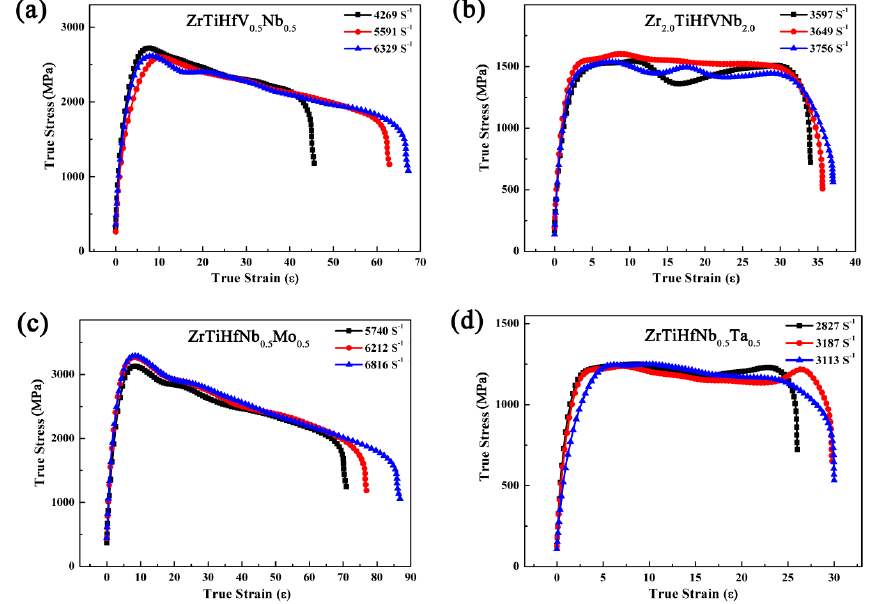
Figure 11. The dynamic compression stress–strain curves of the RHEAs: ( a ) ZrTiHfV 0.5 Nb 0.5 ; ( b ) Zr 2.0 TiHfVNb 2.0 ; ( c ) ZrTiHfNb 0.5 Mo 0.5 ; ( d ) ZrTiHfNb 0.5 Ta 0.5 .